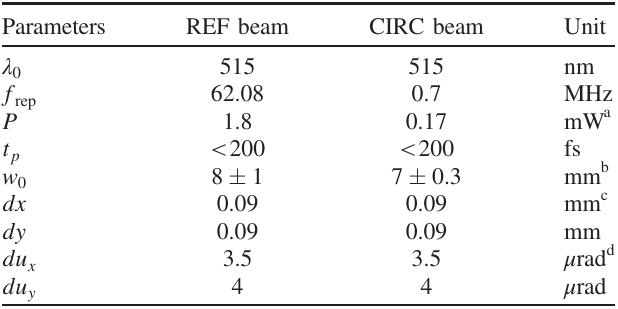
TABLE V. Parameters of the synchronization and alignment laser-beam tool, see text for details.